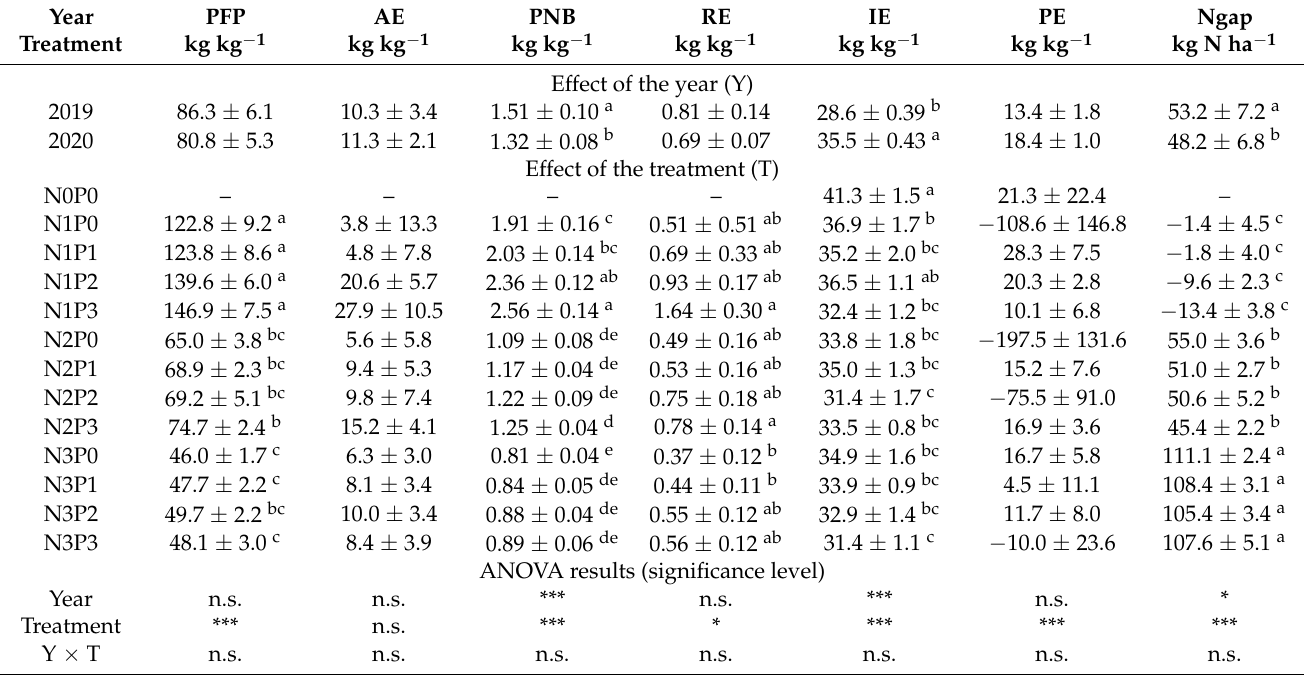
Table 2. Nitrogen use efficiency (NUE) indices depending on fertilization